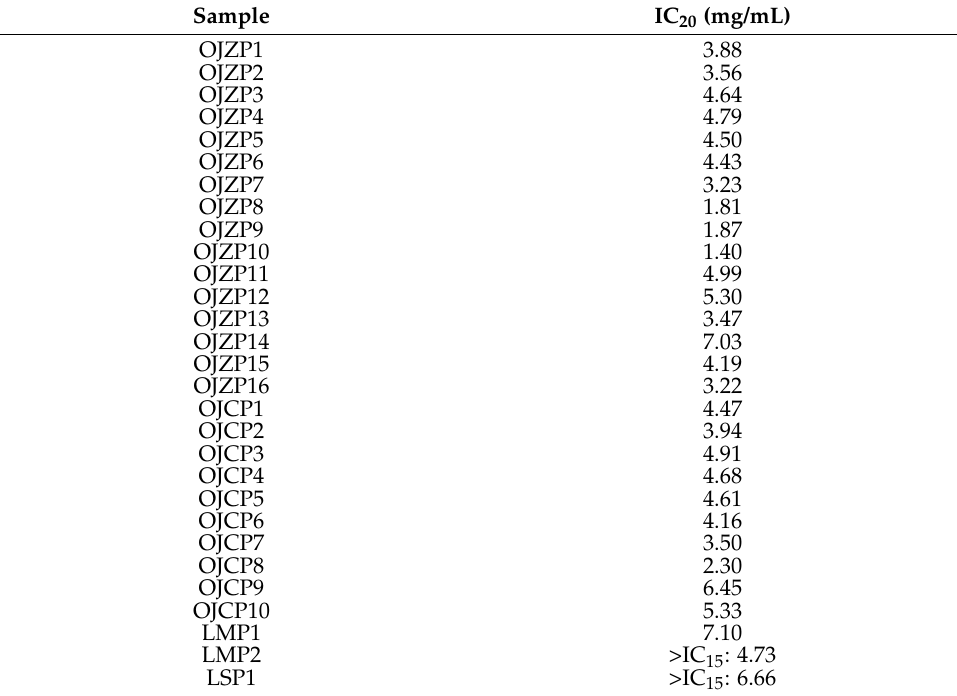
Table 4. ABTS free radical scavenging ability of MaiDong